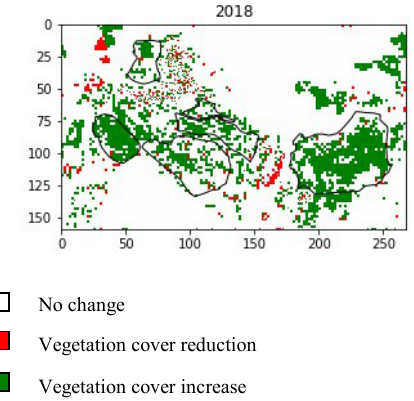
Figure 9. Change detection map between the autumn of 2016 and the autumn of 2018. The reference year is